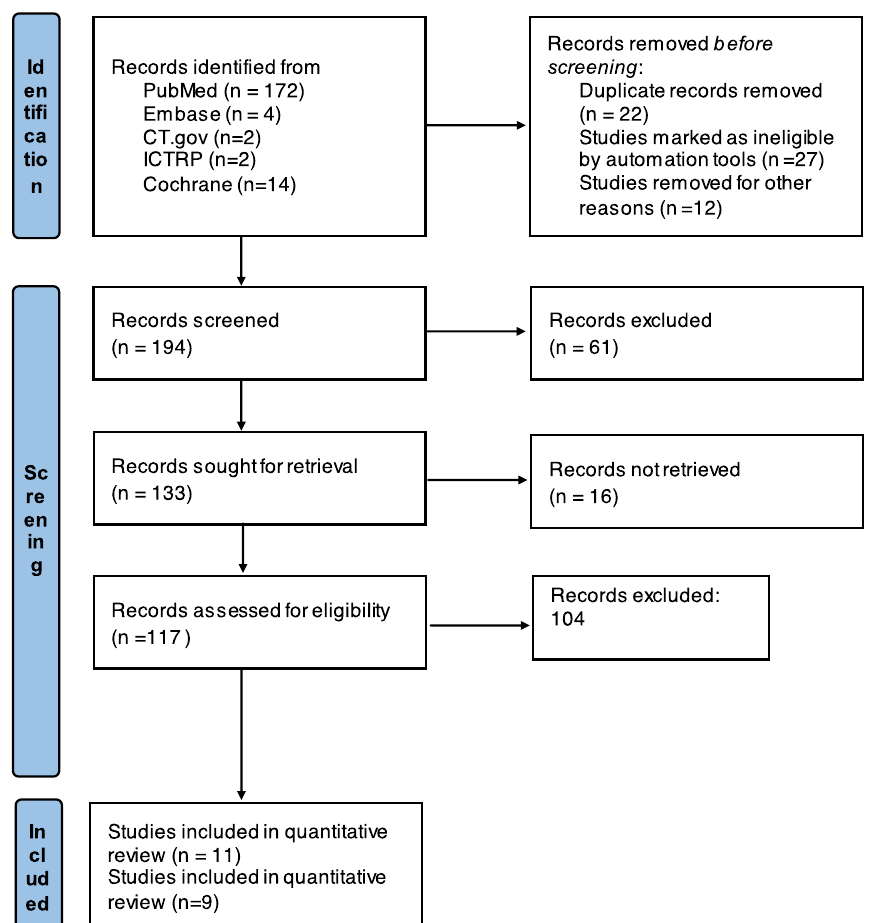
Figure 1. Preferred reporting items for systematic reviews and meta-analyses (PRISMA) fl ow